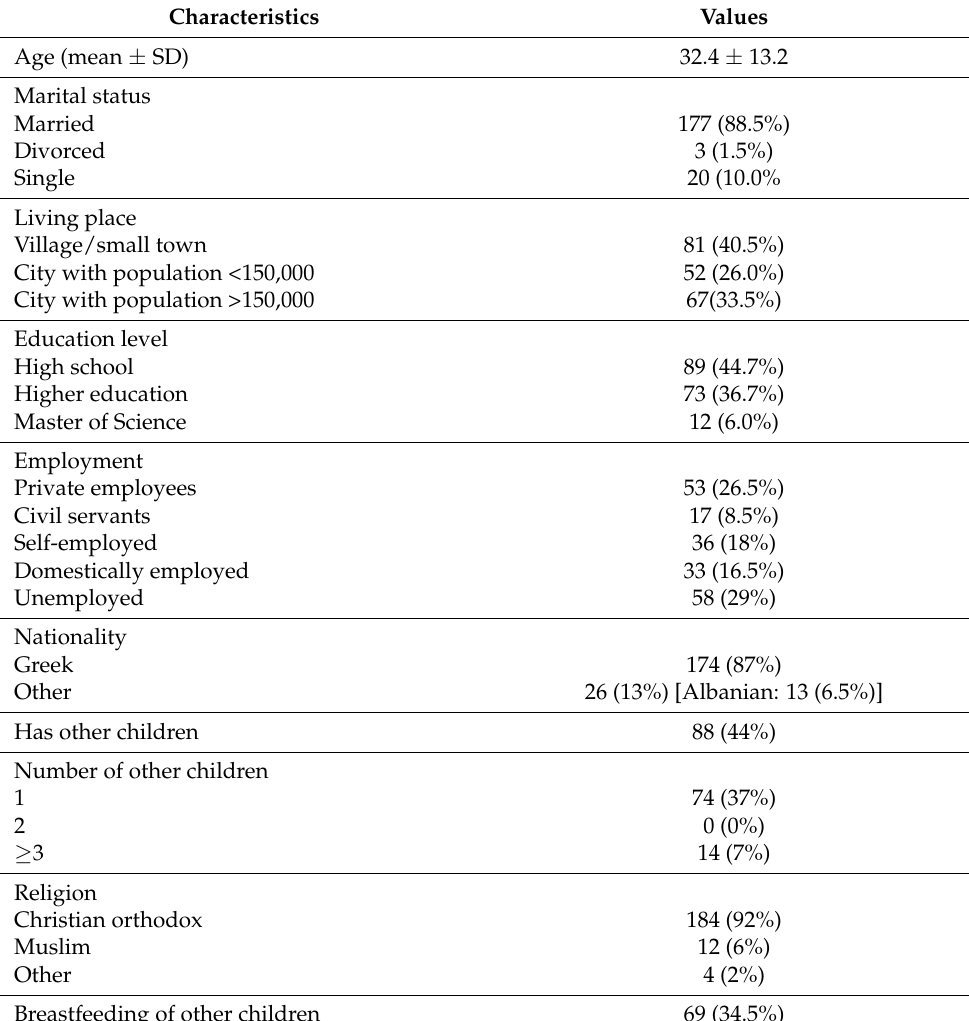
Table 2. Baseline descriptive characteristics of the study